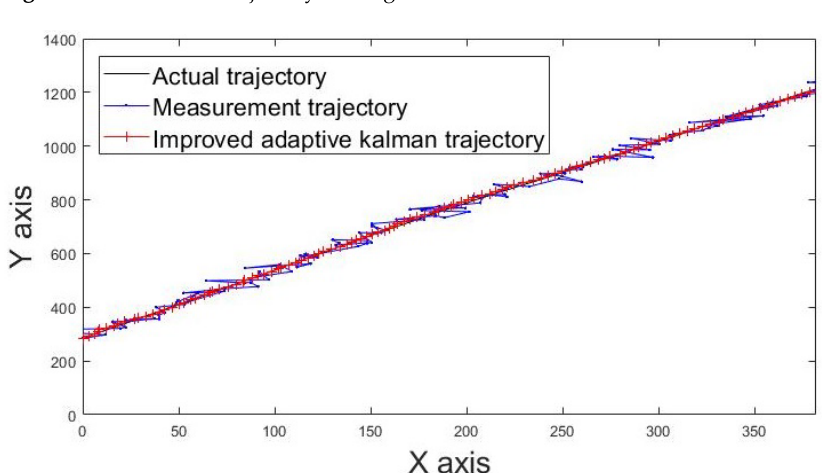
Figure 14. Movement trajectory 2 of tag.